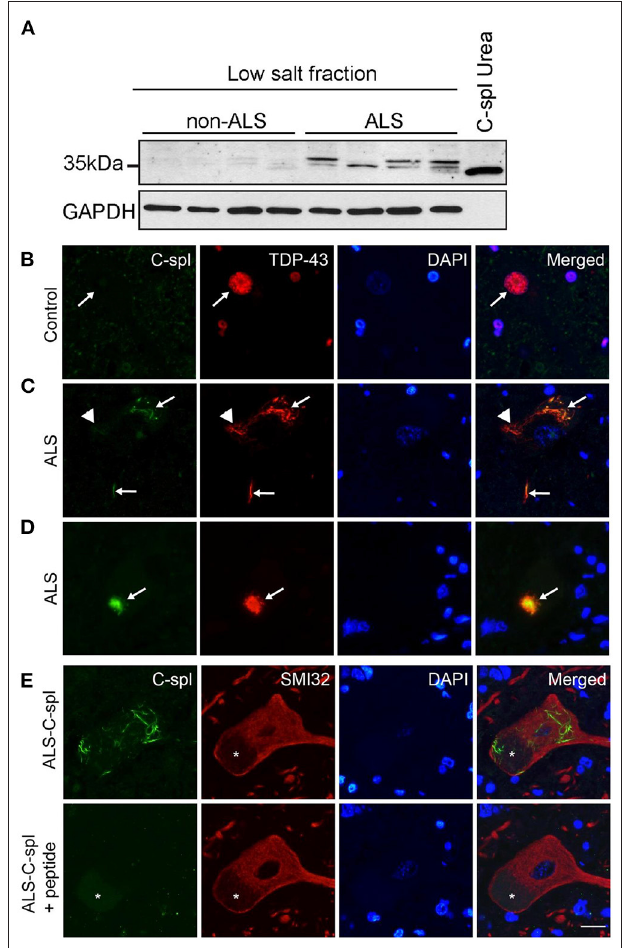
FIGURE 8 | TDP43C-spl/sTDP-43 isoforms are incorporated into TDP-43 positive pathological inclusions in ALS motor neurons. (A) Lysates of non-ALS ( n = 4) and ALS ( n = 4) lumbar spinal cord show increased expression of TDP43C-spl/sTDP43 in ALS cases compared to controls. GAPDH is used as a loading control and lysate of N2a cells transiently transfected with TDP43C-spl was used as a positive control. Double immunofluorescence staining of spinal cord motor neurons of (B) control and (C–E) ALS cases with CTUS antibody (green); TDP43-FL (red); and DAPI stain. (B) In control cases, there was no apparent CTUS staining in the nucleus (arrows). Note that in (C,D) there was co-labeling of CTUS antibody with TDP43-FL in (C) skein-like inclusions (arrows), and (D) round inclusions (arrows), however this co-labeling was only partial (arrowheads). (E) Specificity of labeling was confirmed by competition with the immunizing peptide on serial sections. Motor neurons were identified using non-phosphorylated neurofilament antibody (SMI32, red). Asterisks indicate lipofuscin. Scale bar = 15 µ